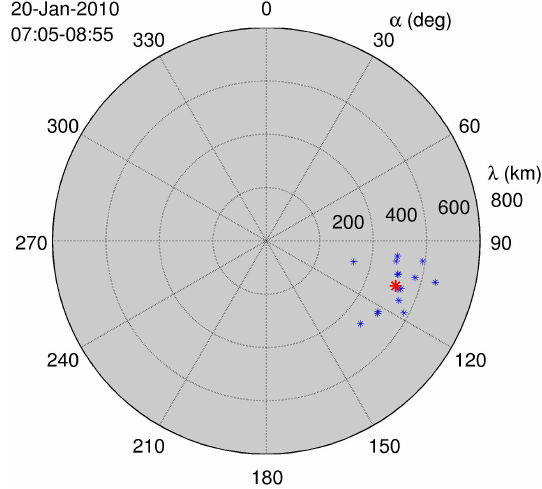
Figure 13. The results of λ x and α x for the samples in the time win- dow centred around 08:00 (blue), and their complex average (red).